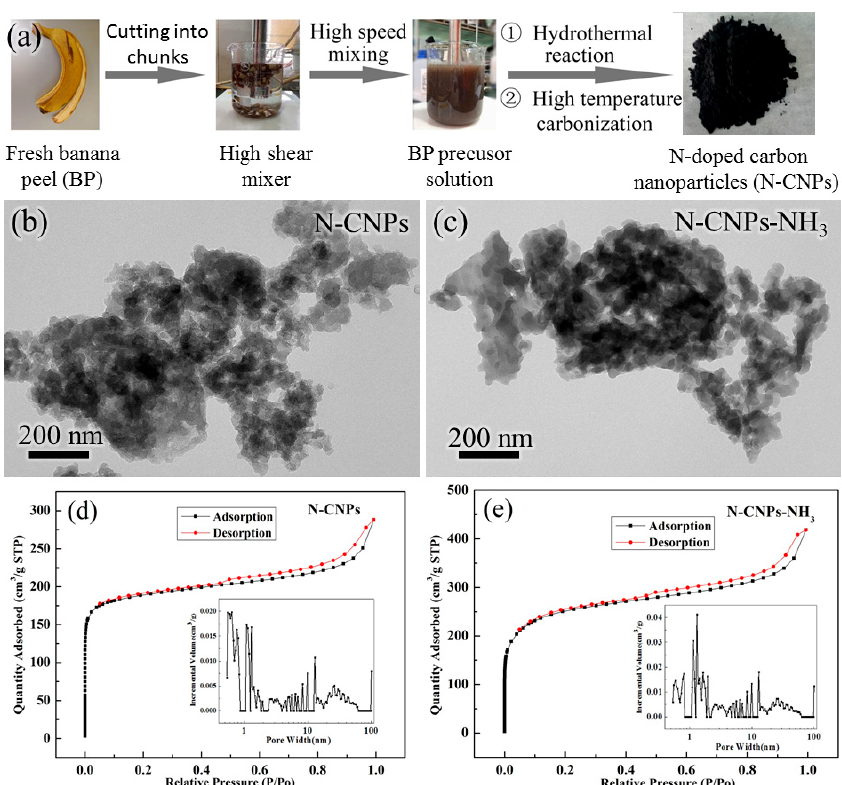
Figure 1. ( a ) Description of process from fresh banana peels to porous carbon. TEM images of ( b ) N-CNPs and ( c ) N-CNPs-NH 3 . Nitrogen sorption isotherms and the corresponding pore size distributions of ( d ) N-CNPs and ( e ) N-CNPs-NH 3 .